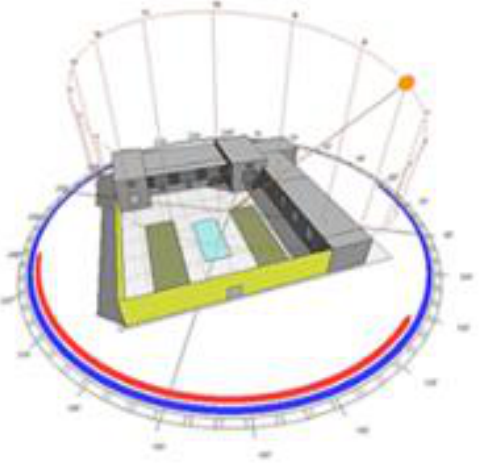
Figure 9 3D view of house No. 1 (7:00 am, July)